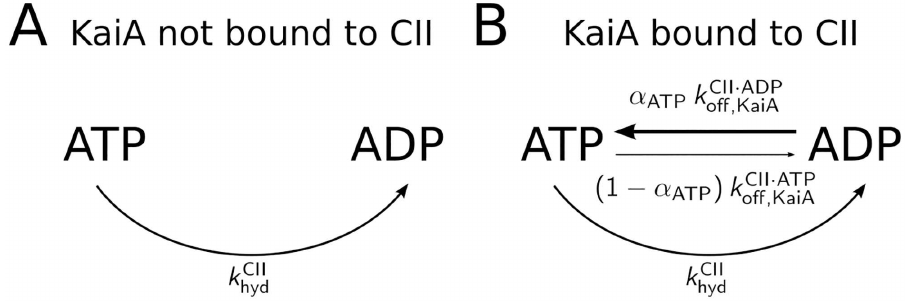
Fig 2. KaiA regulates the fraction of ATP in the CII binding pockets by increasing the nucleotide dissociation rates, in combination with the ATPase activity in the CII domain. A) Without KaiA bound to CII, the nucleotide dissociationrates are identicallyzero, and there is no nucleotide exchangewith the bulk. Since ATP is hydrolyzedat a constant rate, k CII , eventuallyall the bindingpockets will be occupiedby ADP. B) hyd When KaiA is bound to the CII domain,it increasesthe dissociationrates of ADP and ATP, k CII (cid:1) ATP and k CII (cid:1) ADP , off off respectively, while leavingthe affinities for ATP and ADP unchanged. Now, ADP in the CII domain is replaced by ATP at a rate that is faster than that at which ATP is hydrolyzed; this indeedincreasesthe fraction of ATP in the bindingpockets. For simplicity, we assumed equal diffusion limited associationrates for ATP and ADP, such that the probabilityof bindingATP after ADP has dissociatedis equal to α ATP . The rate of the reverse pathway is proportional to the bulk ADP fraction, 1 − α ATP